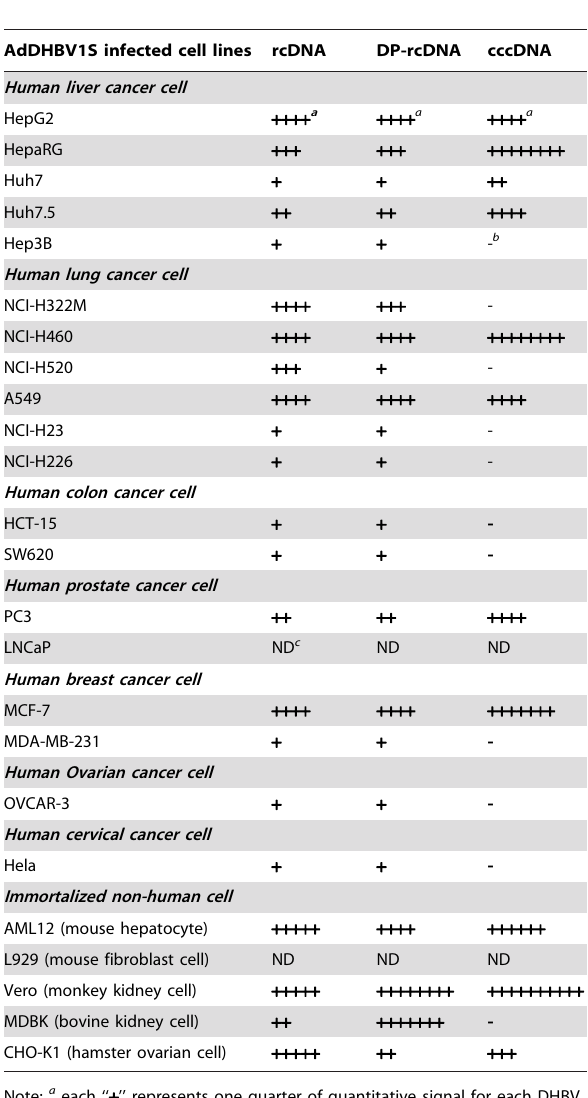
Table 1. Cell Permissiveness on DHBV replication, deproteinization and cccDNA